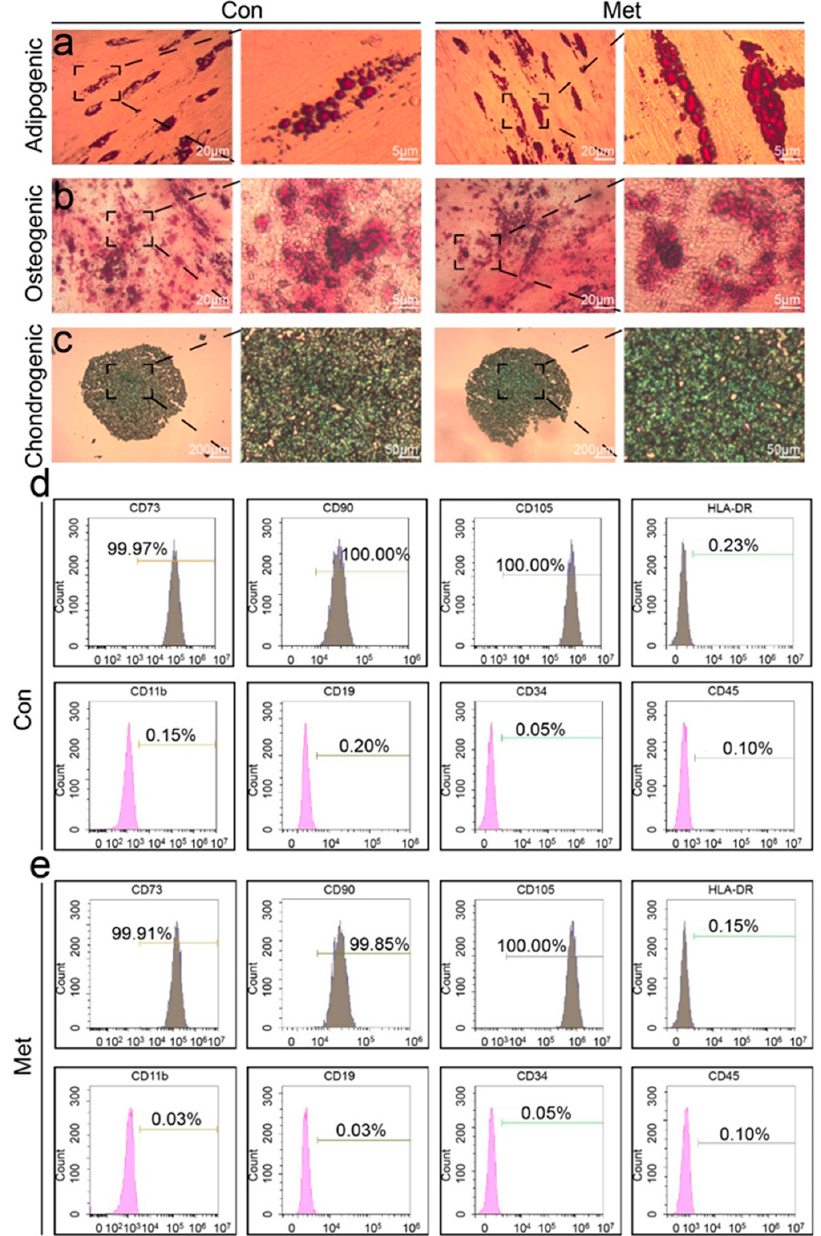
Figure 2. Characterization of GMSCs and Met–GMSCs. ( a ) Oil red O staining image after induction by only adding adipogenic induction medium (Con) and adipogenic induction medium containing metformin (Met). Scale bar = 20 μ m, 5 μ m. ( b ) Alizarin red staining image after only adding oste-